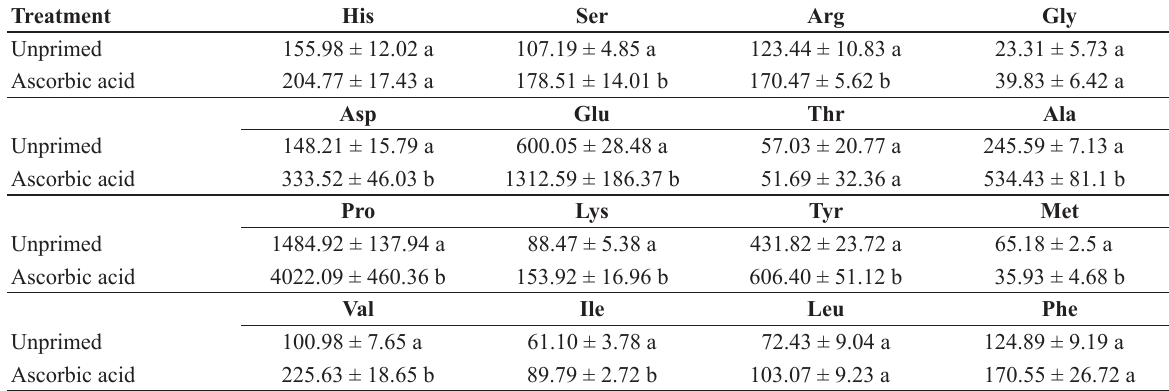
Soluble amino acids in the DA variety maize kernels (µg.g -1 dM).